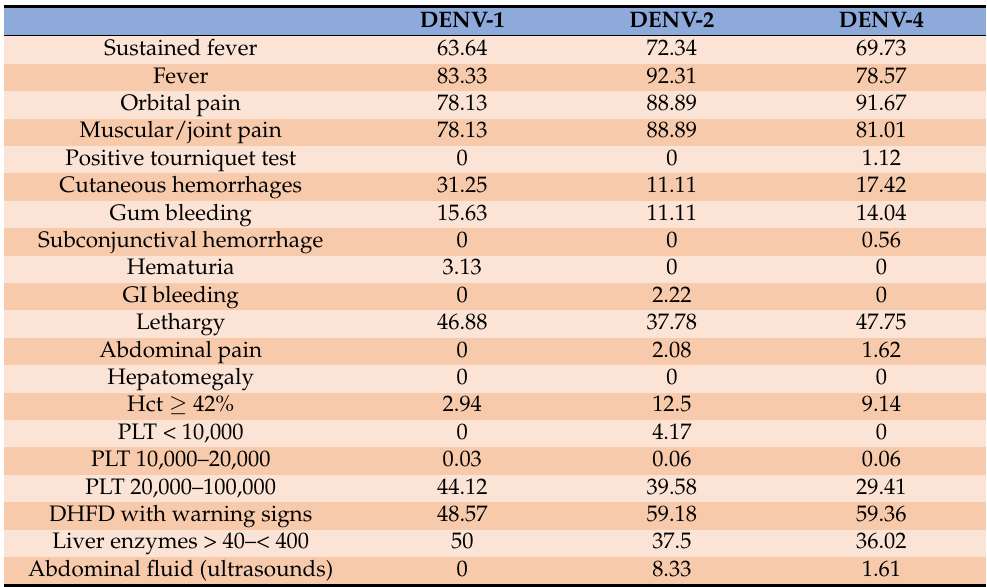
Table 4. Clinical manifestations and subclinical findings associated with different DENV serotypes in patients diagnosed with DHF. DENV-1 DENV-2 DENV-4 Sustained fever 63.64